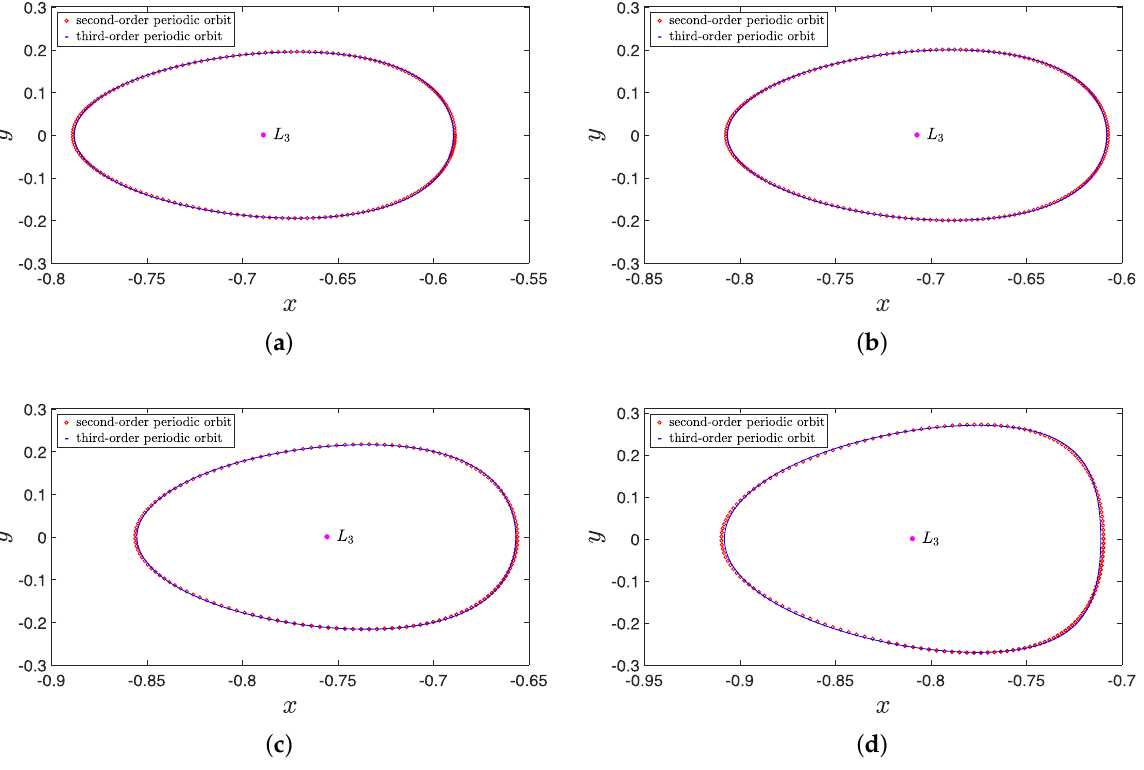
Figure 4. Approximate periodic orbits near the Lagrangian point L 3 when ( a ) k = − 0.1, ( b ) k = 0, ( c ) k = 0.3, and ( d ) k = 0.7,